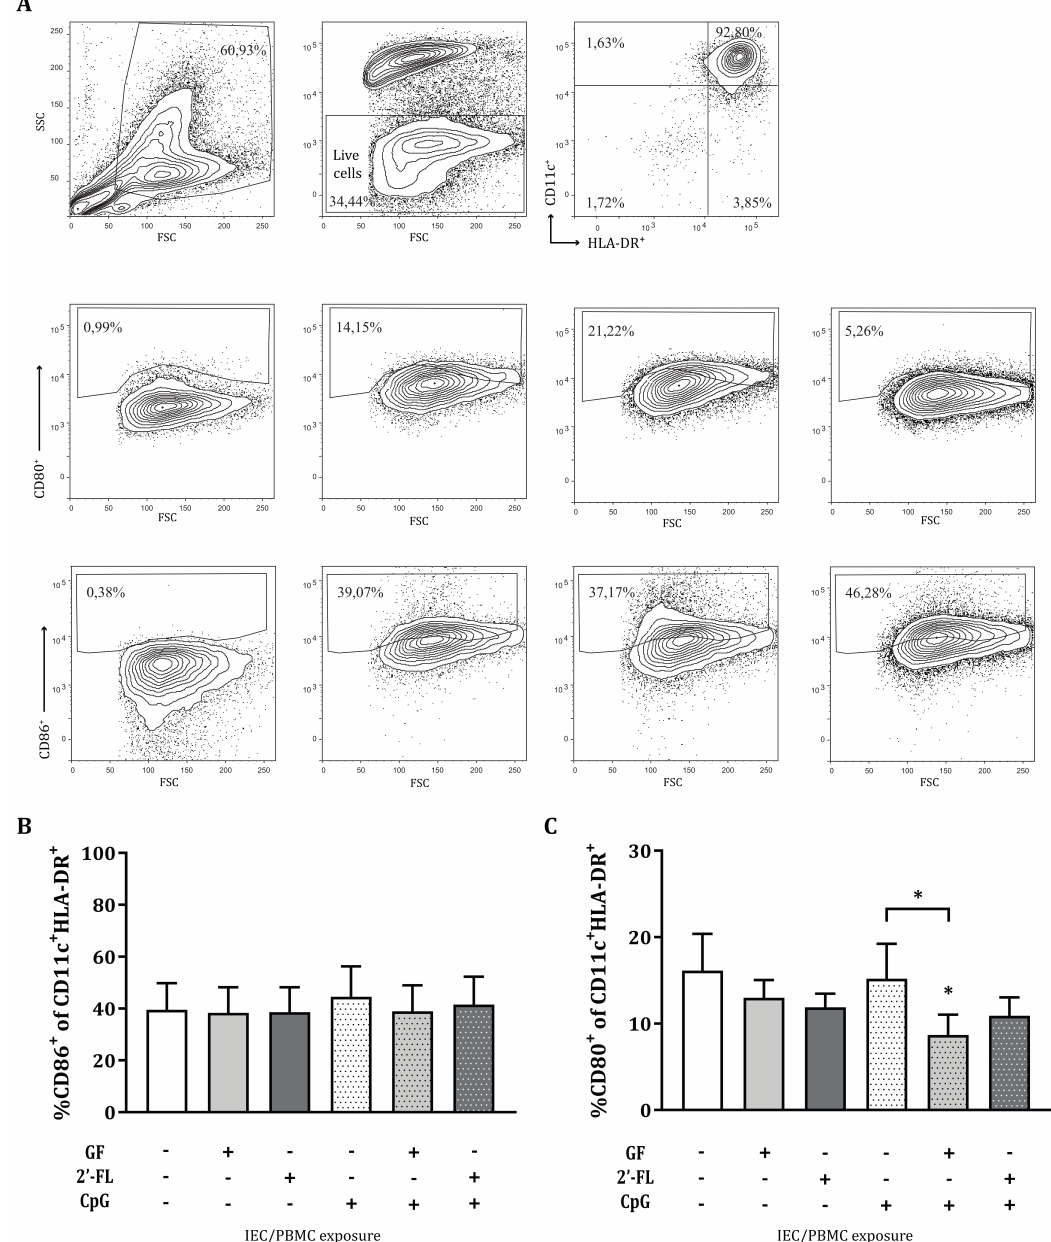
Figure 6. Phenotype of moDC after IEC / moDC co-culture. After exposure of IEC to 0.5% 2 (cid:48) -FL or GF, in the absence or presence of CpG, and co-culture with α CD3 / CD28-activated PBMC, IEC were washed and co-cultured with immature moDC for 48 h (Figure 1C). The phenotype of moDC was studied after co-culture. Representative FACS plots are shown in ( A ). Expression of CD86 + ( B ) and CD80 + ( C ) was determined in the CD11c + HLA-DR + population. Data are represented as mean ± SEM of eight independent moDC donors (* p <